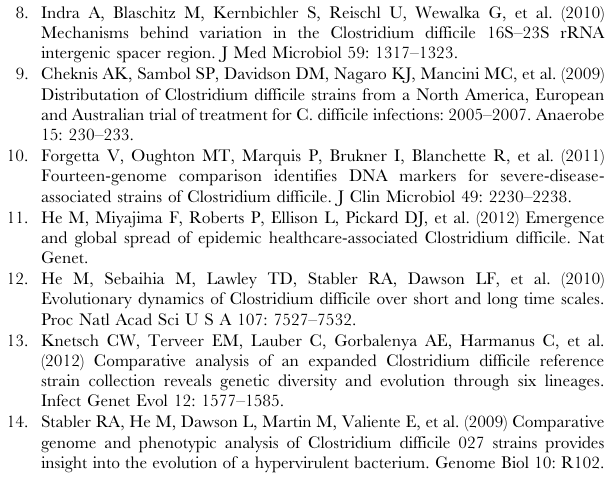
Figure S11 RNA polymerase A gene-based dendrogram. Neighbor joining dendrogram reflecting the similarity for all 48 analyzed C. difficile strains based on the gene for RNA polymerase A. The distance matrix was computed using the Hamming distance with the RNA polymerase A genes from all 48 C. difficile isolates. The strains always cluster according to their PCR ribotype. The PCR-ribotype is indicated in brackets. Figure S12 RNA polymerase B gene-based dendrogram. Neighbor joining dendrogram reflecting the similarity for all 48 analyzed C. difficile strains based on the gene for RNA polymerase B. The distance matrix was computed using the Hamming distance with the RNA polymerase B genes from all 48 C. difficile isolates. The strains always cluster according to their PCR ribotype. The PCR-ribotype is indicated in brackets. Figure S13 RNA polymerase C gene-based dendrogram. Neighbor joining dendrogram reflecting the similarity for all 48 analyzed C. difficile strains based on the gene for RNA polymerase C. The distance matrix was computed using the Hamming distance with the RNA polymerase C genes from all 48 C. difficile isolates. The strains always cluster together according to their PCR ribotype. The PCR-ribotype is indicated in brackets. Figure S14 Dendrogram based on the concatenated sequences of the 14 conserved genes. Neighbor joining dendrogram reflecting the similarity for all 48 analyzed C. difficile strains based on the concatenated sequences of the 14 conserved genes. The distance matrix was computed using the Hamming distance with these sequences from all 48 C. difficile isolates. The strains always cluster according to their PCR ribotype. The PCR- ribotype is indicated in brackets. Strains with ribotype 027 build two sub-clusters. Figure S15 Binary toxin A gene-based dendrogram. Neighbor joining dendrogram reflecting the similarity for all 22 analyzed C. difficile strains based on the gene for binary toxin A. The distance matrix was computed using the Hamming distance with the binary toxin A genes from all 22 C. difficile isolates. The strains always cluster according to their PCR ribotype. The PCR- ribotype is indicated in brackets.